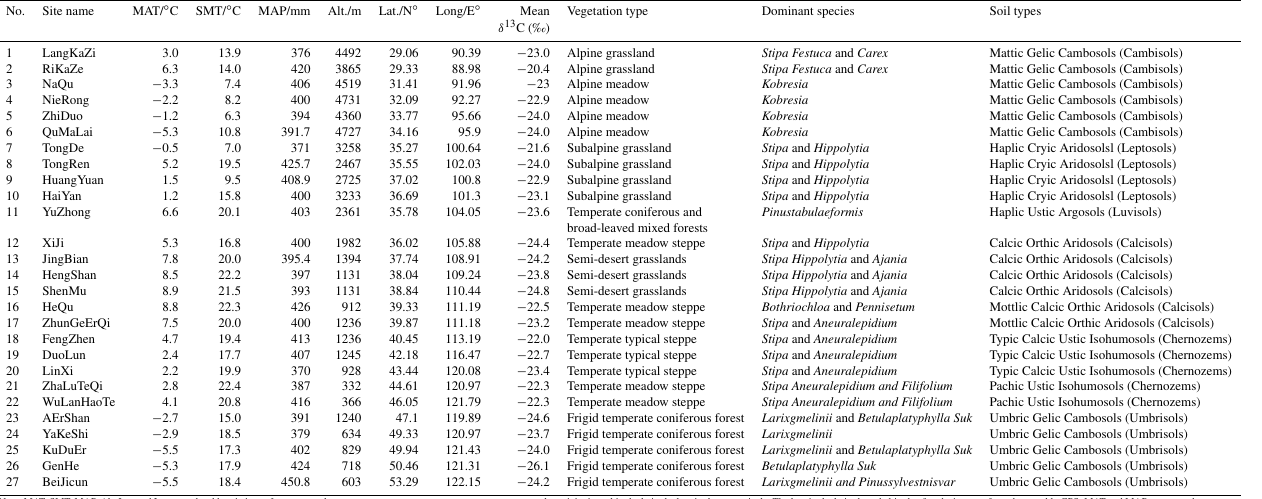
Table 1. Information of the sampling sites. No.